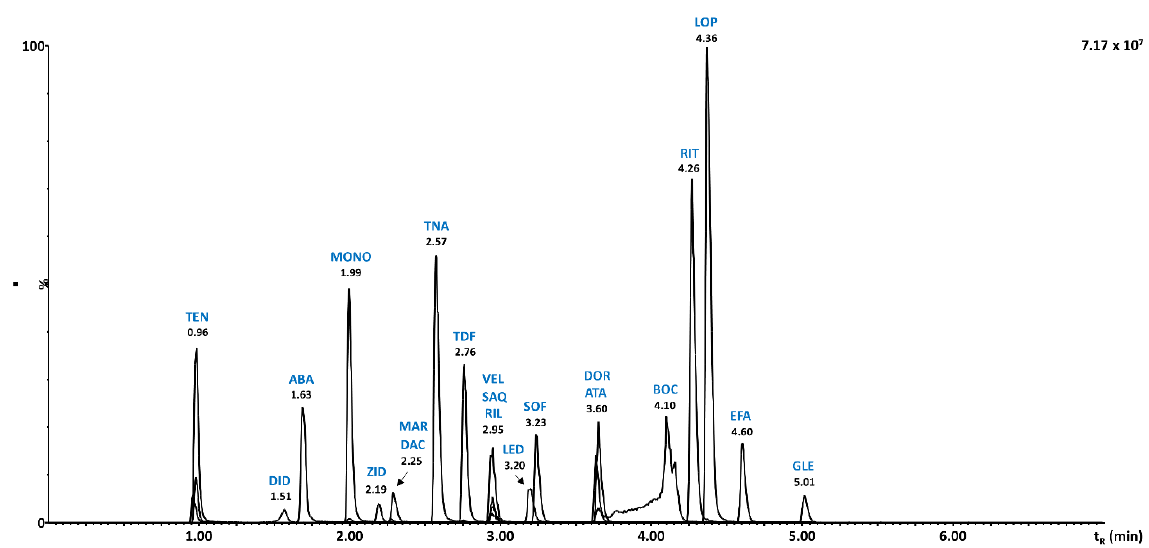
Figure 2. RP-UHPLC-MS/MS chromatogram of 21 antiviral drugs using optimized separation conditions: BEH Shield RP18 stationary phase, gradient elution using 25 mmol/L formic acid in water with the addition of 0.1% of medronic acid and ACN with addition 0.1% medronic acid, gradient program from 5% ACN to 98% ACN in 5 min, injection volume 2 µ L, and flow rate 0.3